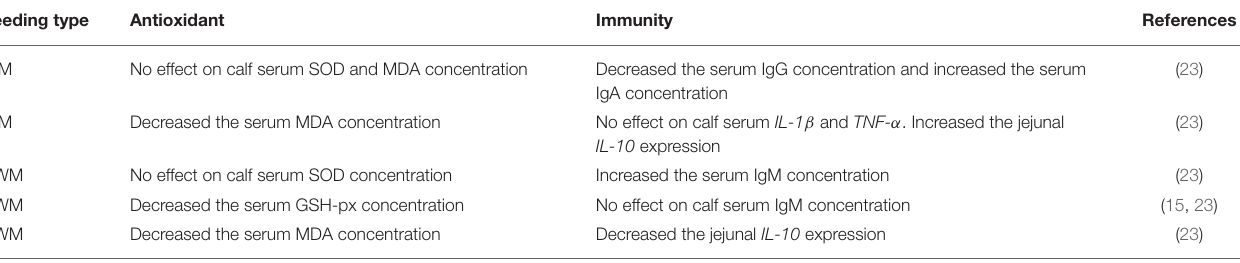
TABLE 4 | Effect of raw WM and PWM on the antioxidant and immunity parameters in calves. Feeding type